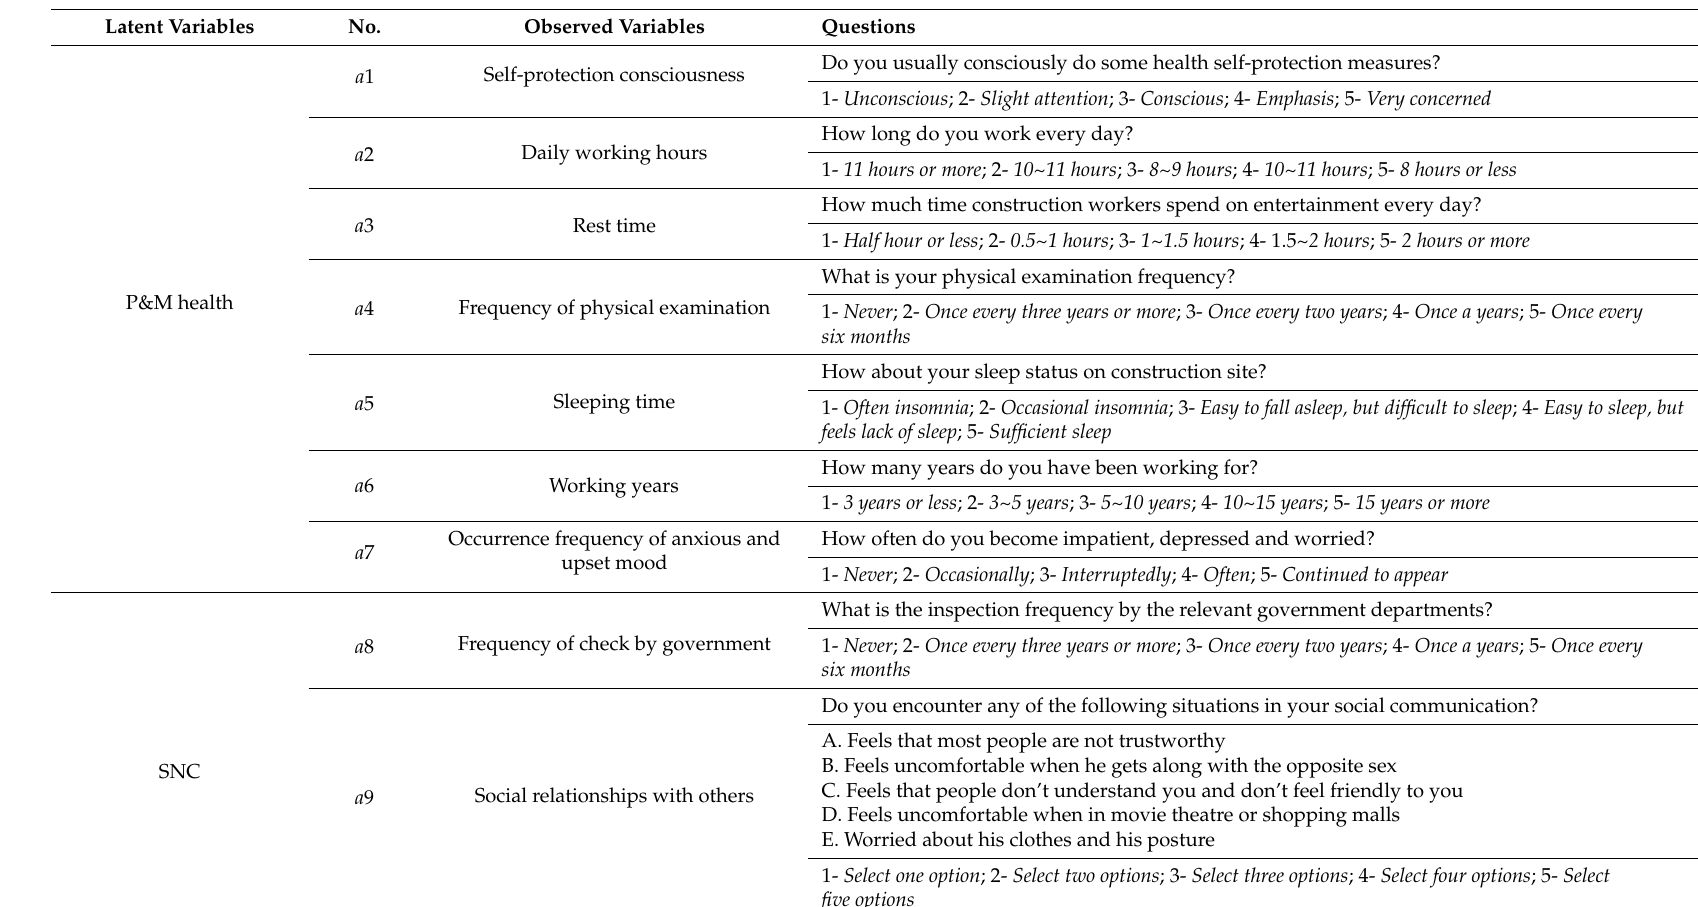
Table 2. The content of the